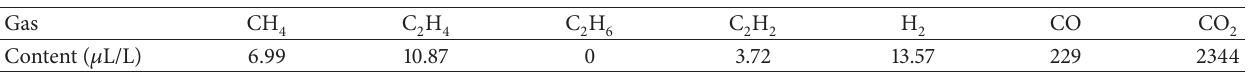
Table 6: DGA result.